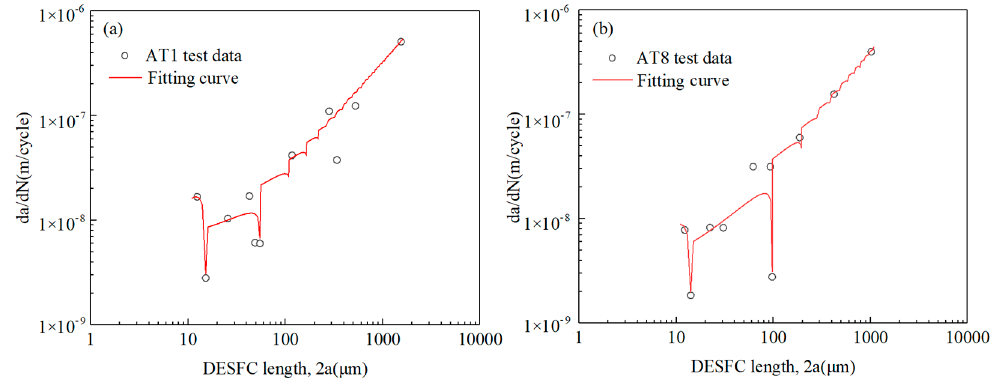
Figure 10. Comparison of the test data and fitting curve using the short cracks model with the non-proportional factor: ( a ) specimen AT1 and ( b ) specimen AT8. Table 3. Parameters of the multi-axial short fatigue growth rate model for AT1 and AT8. Specimen AT1